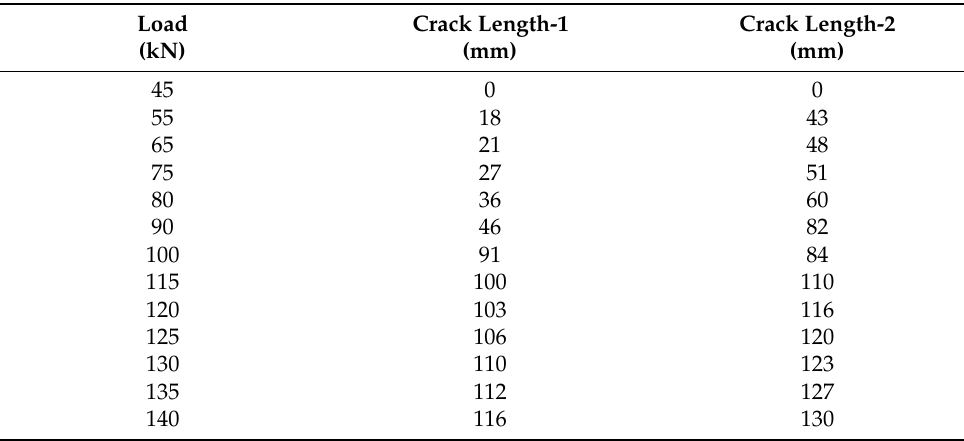
Figure 3. Crack propagation of the prestressed sleeper at midspan. Table 3. Experimental results of load-crack length response.